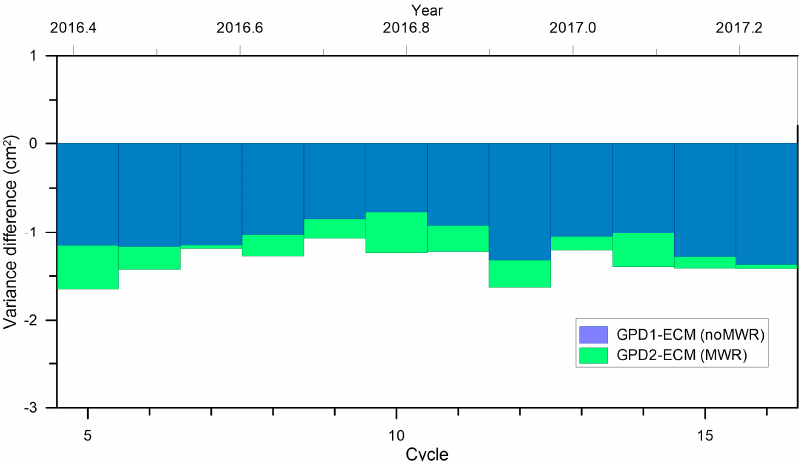
Figure 18. ( Top panel ): temporal evolution of weighted SLA variance differences at crossovers for SLA datasets computed using the WTC from the S3A MWR and ECMWF (orange) and the WTC from GPD1 and ECMWF (blue) using only points with a valid MWR; ( Bottom panel ): temporal evolution of weighted SLA variance differences at crossovers between SLA datasets computed using the WTC from GPD1 and that from ECMWF (blue) and between GPD2 and ECMWF (green), using all points with valid SLA.